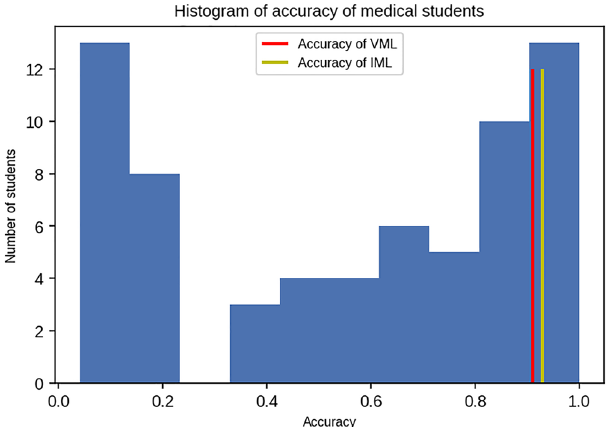
Figure 8. Histogram of accuracy of 66 medical students in the quiz questionnaire; the accuracy of VML and IML are shown for comparison (Figure generated by Matplotlib python library, version 3.3.4, https:// matpl otlib. org/).